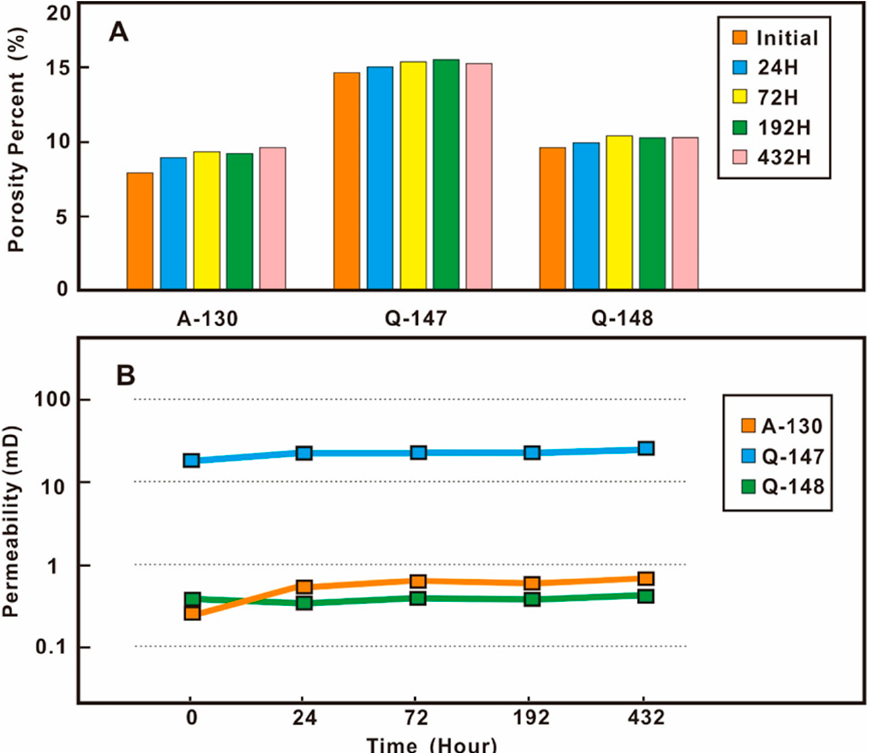
Figure 11. The porosity and permeability changes of samples at different experiment times. ( A ) porosity; ( B ) permeability.